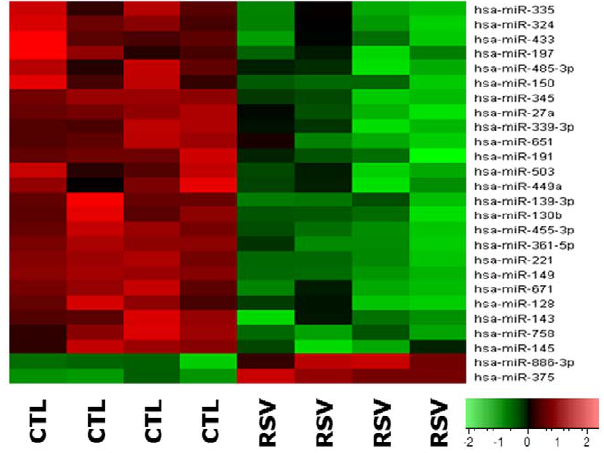
Figure 1. RSV-induced change in microRNAs expression. This heat map was generated using differentially expressed genes based on unadjusted t-test p-values, and provides an overall picture of the impact of RSV infection on the human bronchial epithelial cell miRNAome as compared to non-infected control cells. Data were partitioned between RSV and control (CTL) samples during the hierarchical clustering and organized into blocks of columns. The rows represent wells in each of the plates, and within each row the green shaded areas indicate lower expression of the specific miRNA noted on the right, whereas the red shaded areas indicate higher expression. Black and darkly shaded areas indicate relatively similar expression between infected and non-infected cells. The Euclidean clustering method was used for array data analysis, and the cutoff level of statistical significance was set at p , 0.01 to reduce clutter. The expression index is shown in the right lower corner.